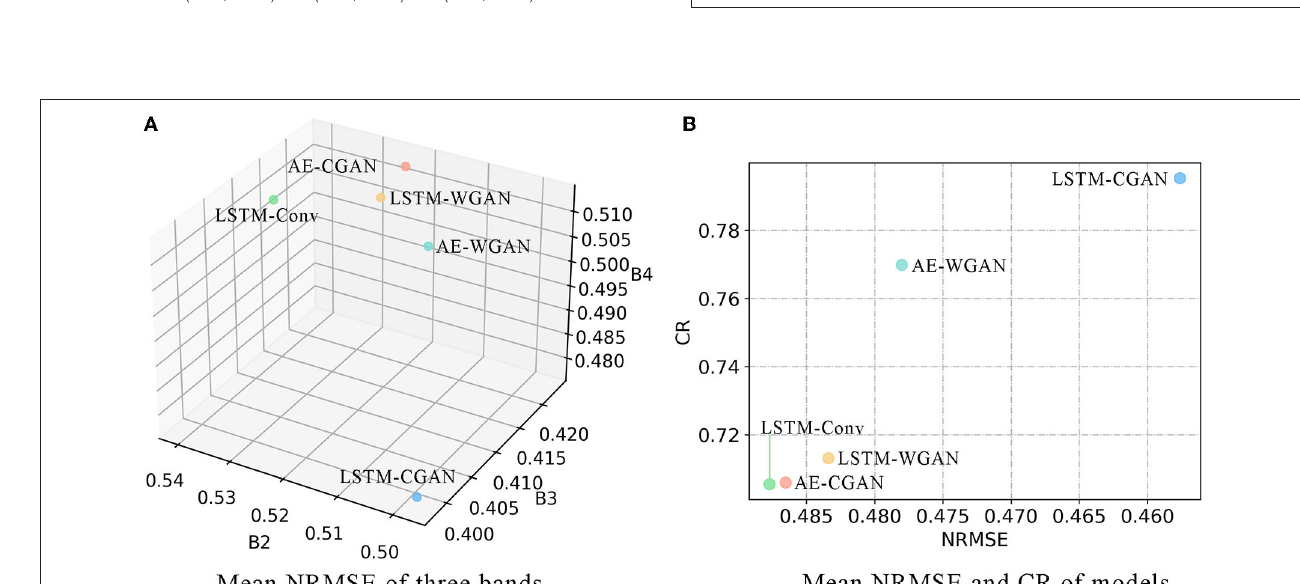
FIGURE 6 | (A,B) LSTM-CGAN scores.